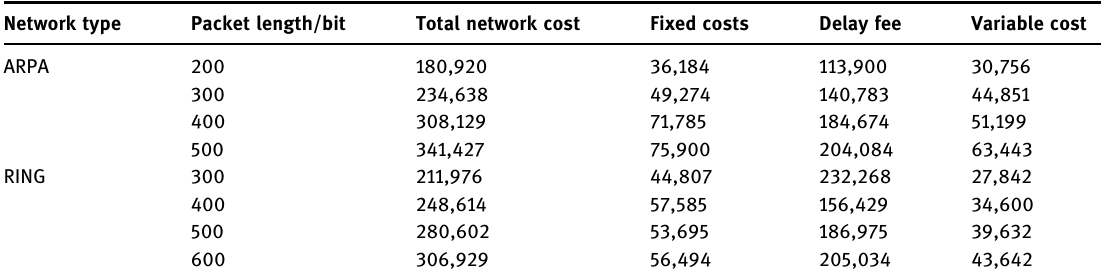
Table 2: Experimental results of computer simulation under di ff erent packet lengths Network